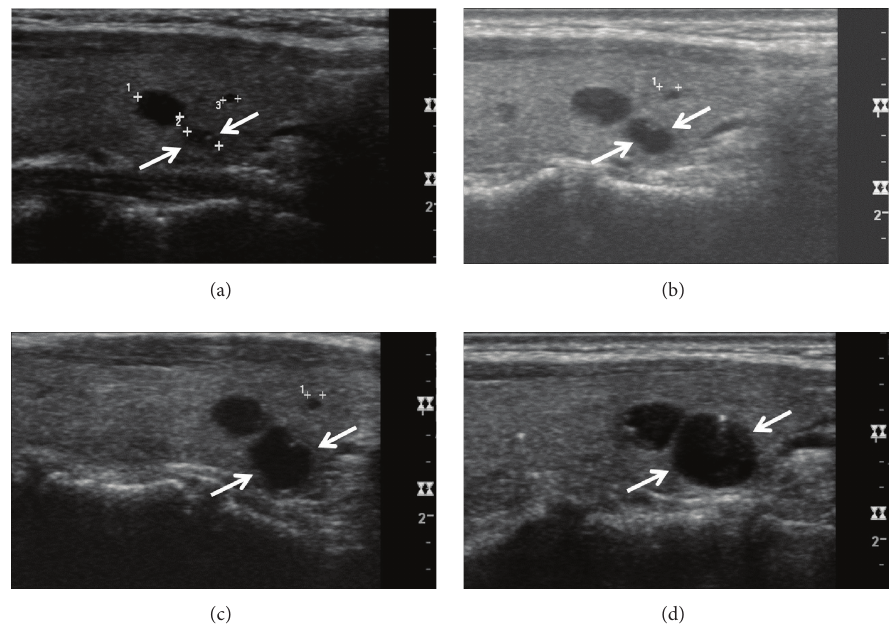
Figure 1: A thyroid colloid cyst with gradual increase in a 50-year-old woman with gradual increase. Longitudinal sonogram (a) shows a colloidcystwithananechoicnoduleandacomet-tailartifactintherightthyroidlobe(arrows,3.3mmatitslargestdiameter).Uponsequential US follow-ups, this colloid cyst demonstrates a gradual increase at a 1-year (b) (arrows, 4.5 mm at its largest diameter), a 2-year (c) (arrows, 6.3 mm at its largest diameter), and a 3-year (d) (arrows, 8.2 mm at its largest diameter) US follow-ups.